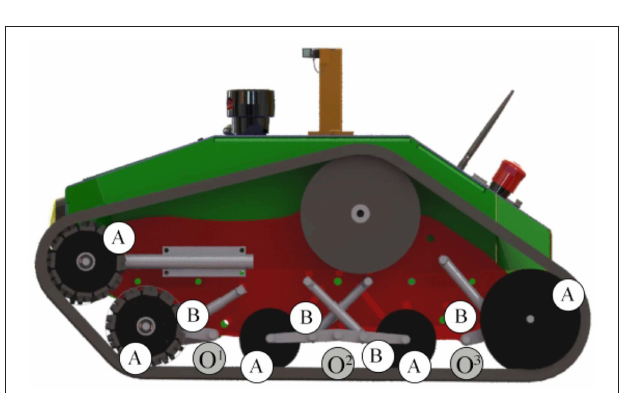
FIGURE 2 | The passive suspension system used for each track made by four linkages and four shock absorbers.